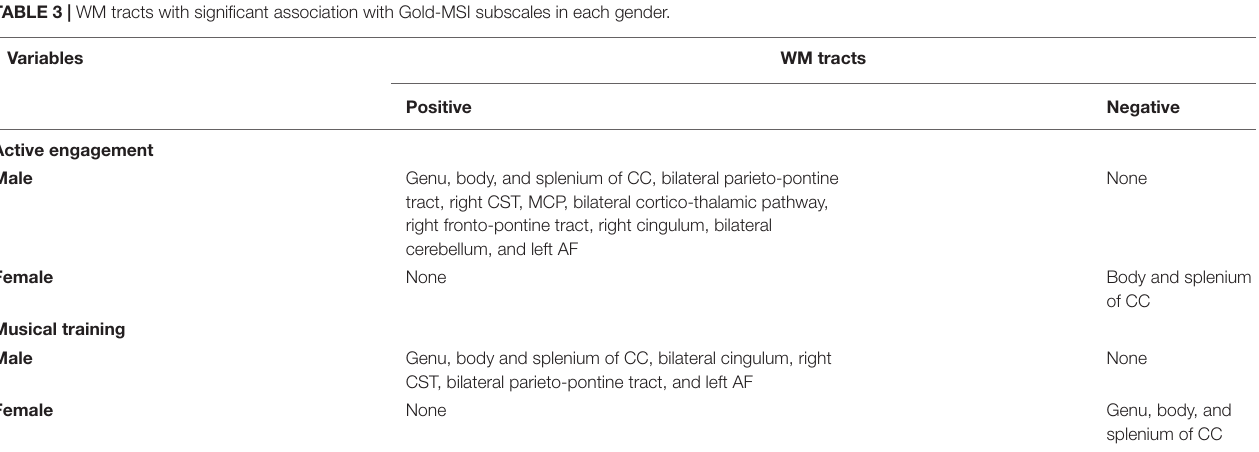
TABLE 3 | WM tracts with significant association with Gold-MSI subscales in each